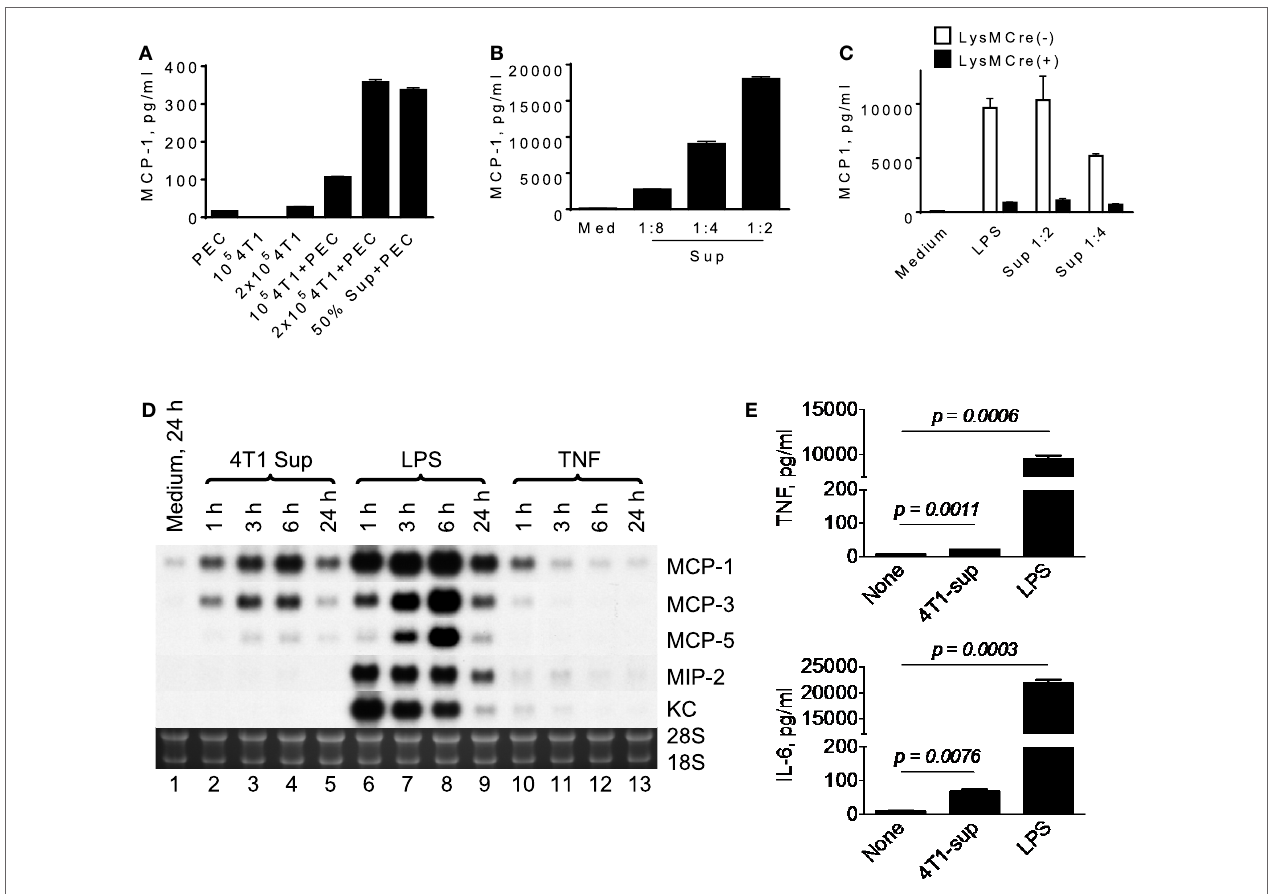
FigUre 1 | a product of 4T1 cells induces McP-1 production by macrophages. (a) 1 × 10 5 or 2 × 10 5 4T1 cells were seeded into six-well plates. After overnight incubation at 37°C, medium was replaced by fresh medium, and 2.5 × 10 6 TG-induced PEC (Balb/c) or an equal volume of 4T1-sup were added. After 24 h-incubation, cell-free culture supernatants were collected, and MCP-1 concentration in each supernatant was measured by MCP-1 ELISA. The results are shown as the mean ± SD, n = 3. (B) Five million TG-induced PEC were cultured in the presence of serially diluted 4T1-sup. After 24 h-incubation, cell-free media were collected, and MCP-1 concentration in each medium was measured by MCP-1 ELISA. The results are shown as the mean ± SD, n = 3. (c) Five million TG-induced PEC from MCP-1 flox/flox or LysMCre + /MCP-1 flox/flox mice were incubated in the presence of 100 ng/ml LPS or 4T1 supernatant. After 24 h-incubation, cell-free media were collected, and MCP-1 concentration in each medium was measured by MCP-1 ELISA. The results are shown as the mean ± SD, n = 3. (D) Two and half million TG-induced PEC were incubated in the presence or absence of 4T1-sup (1:1), 100 ng/ml LPS, or 10 ng/ml TNF α . Total RNA was extracted and subjected to Northern blotting. (e) Two million TG-induced PEC were cultured in the presence of 4T1-sup (1:1). After 24 h-incubation, cell-free media were collected, and TNF α or IL-6 concentration in each medium was measured by Cytometric Bead Array. The results are shown as the mean ± SD, n =